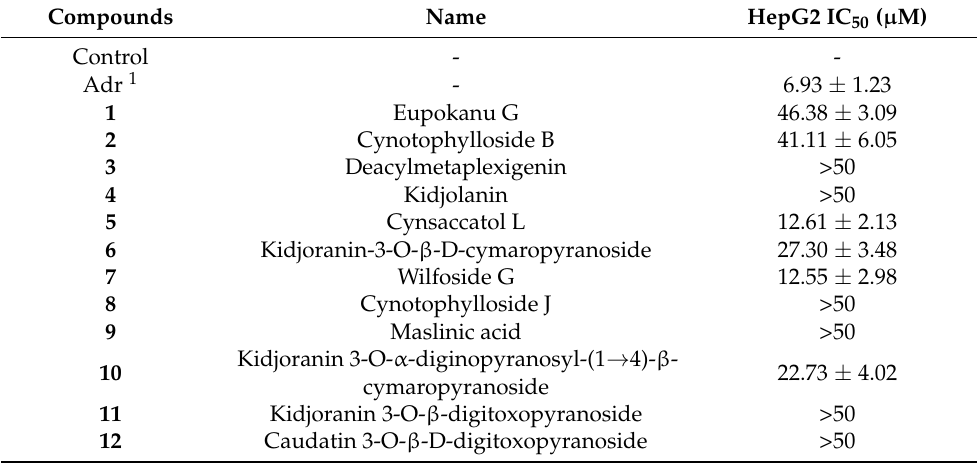
Table 2. Cell viability of HepG2 cells treated by compounds 1 – 12 .